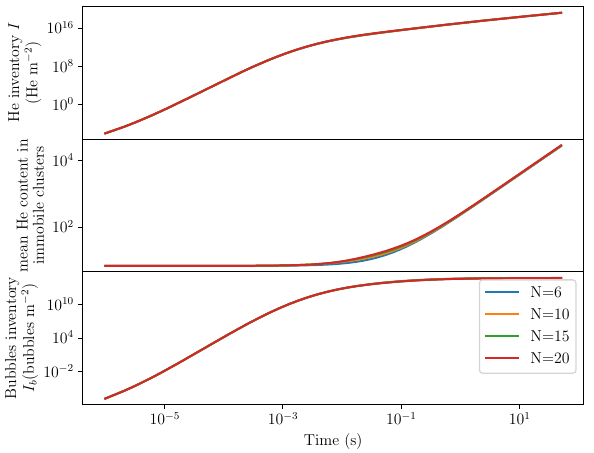
Figure 9. Comparison of several quantities of interest for several values of N in W exposed to 100 eV He at 10 20 m − 2 s − 1 and 1000 K.